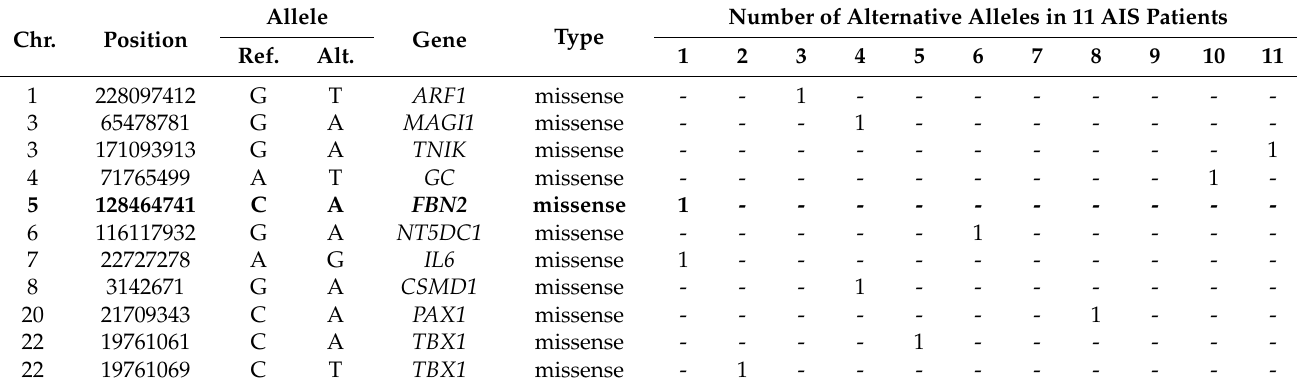
Table 2. Rare variants in AIS-related